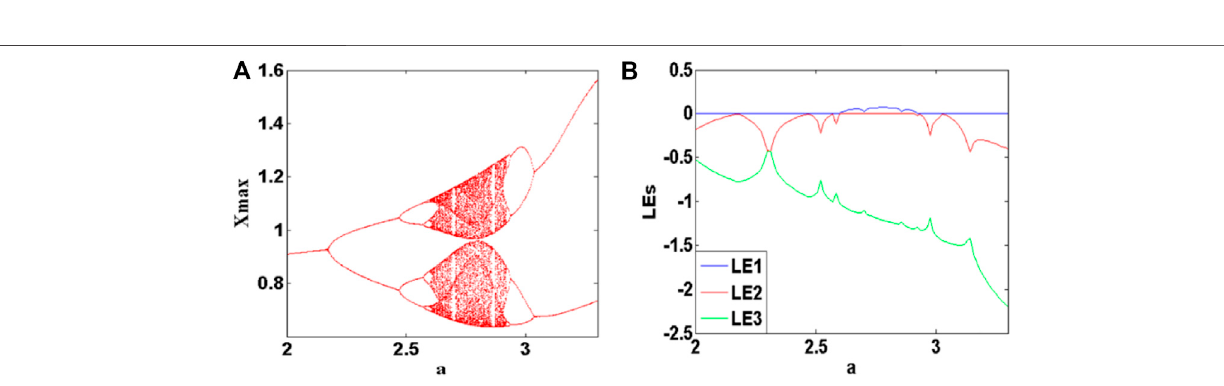
FIGURE 7 | Offset boosted attractors of system (8) with a (cid:1) 2.4, b (cid:1) 0.5, c (cid:1) 1.7,and d (cid:1) 2.5: (A) attractors on plane of x-z , (B) signal x (t).